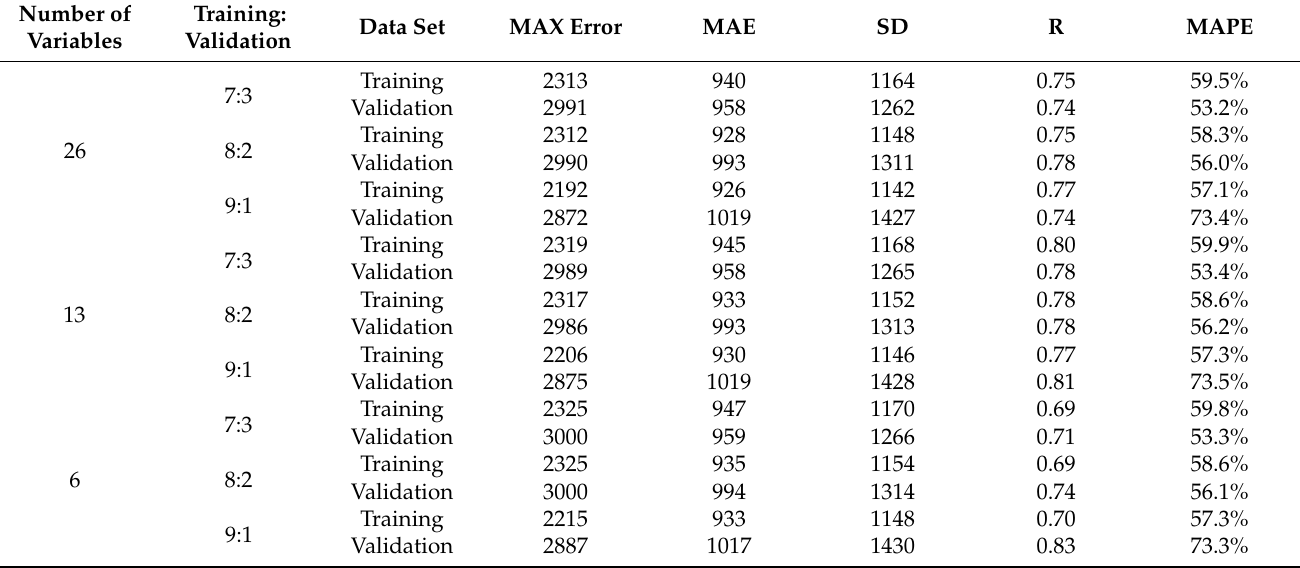
Table A11. Analysis of the results of the SVM model for natural gas consumption.